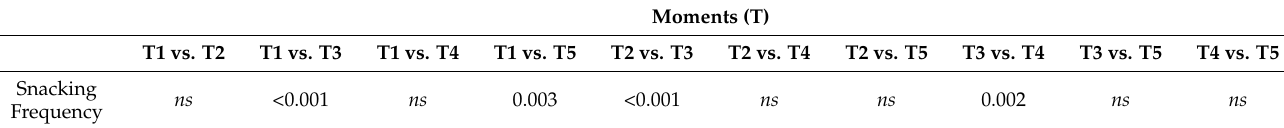
Table 3. Post hoc comparisons of snacking frequency across the five moments (T1–T5). Moments (T)